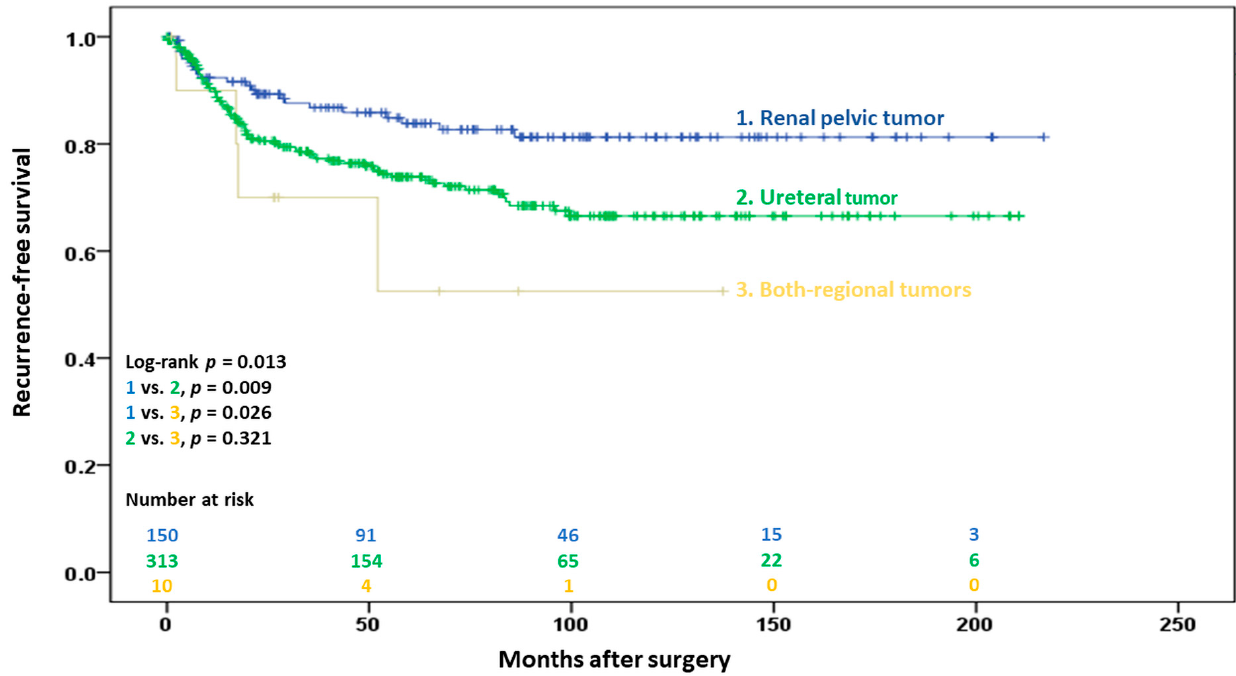
Figure 2. Kaplan–Meier estimates of extraurinary tract recurrence-free survival in 476 patients following radical surgery for pT2 upper urinary tract urothelial carcinoma, with stratification by tumor location.